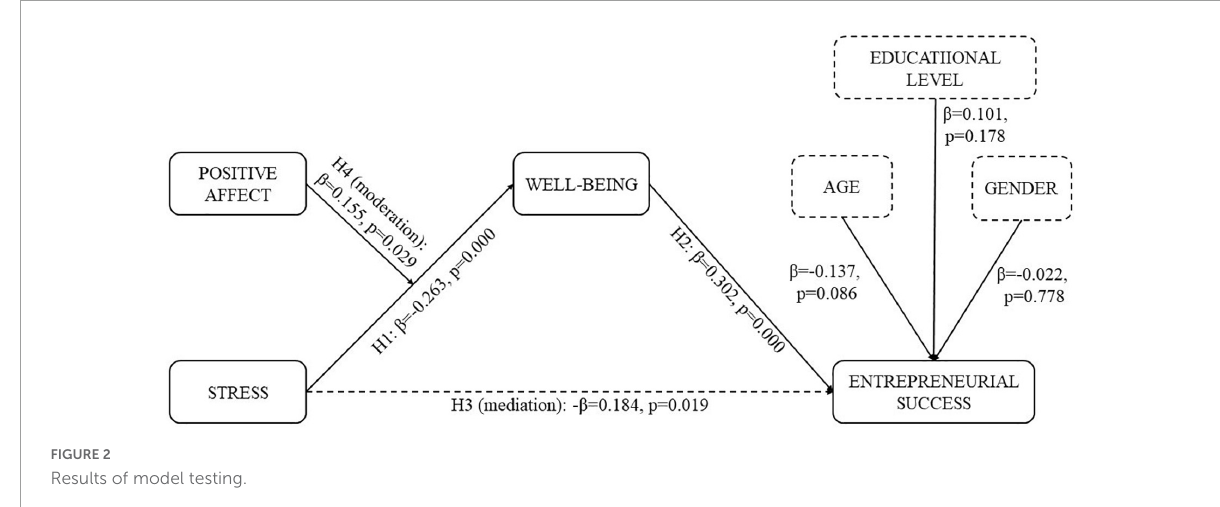
TABLE 2 Results for the decomposition of effects in the moderated mediation model using a bootstrap method. Wellbeing Entrepreneurial success P -value P -value Unstd. Std. Std. Unstd. Std. Std. coefficient error coefficient (two-tailed coefficient error coefficient significance)